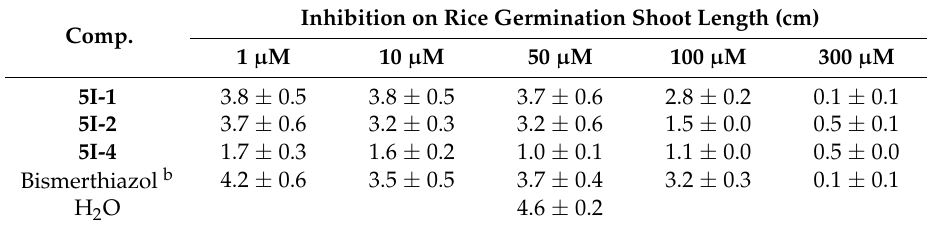
Table 5. Phytotoxicity of target bactericidal compounds on rice germination a . Comp.